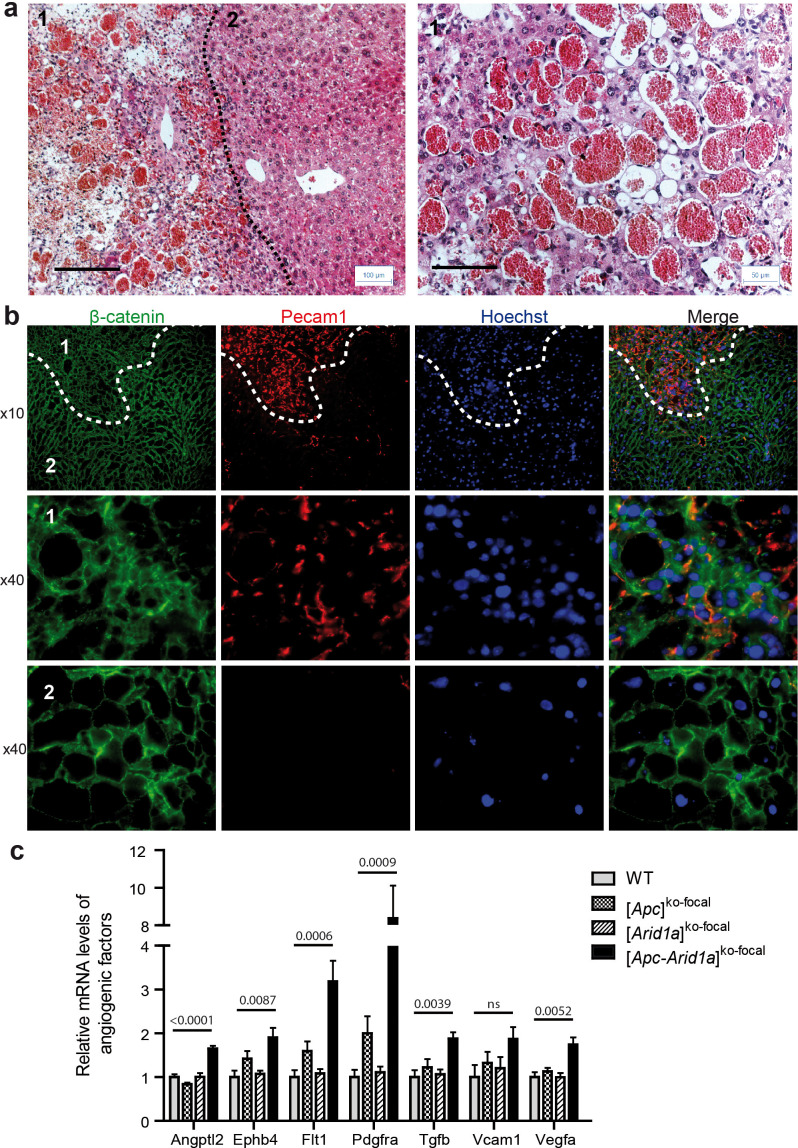
Blood vessel enrichment and angiogenesis in [Apc-Arid1a]ko-focal livers.(a) Peliotic areas appeared as abnormal tangles of irregularly shaped, leaky, small and large blood vessels filled with red blood cells, with multiple, mottled cyst-like spaces associated with sinusoidal dilatation and liver cell dropout in the livers of [Apc-Arid1a]ko-focal mice (1), relative to neighboring tissue (2). Scale bars = 200 μm (left panel) and 100 μm (right panel). (b) Immunofluorescence, at different magnifications, against β-catenin and Pecam1 of [Apc-Arid1a]ko-focal liver. Peliosis-like area, showing strong enrichment of blood vessels (1) compared to neighboring tissue (2). (c) RT-qPCR analysis of angiogenic factors from 7-month-old-mouse livers. WT (n = 5), [Apc]ko-TOTAL (n = 7), [Arid1a]ko-TOTAL (n = 12), and [Apc-Arid1a]ko-TOTAL (n = 10) mice. Data are presented as the mean + SEM and analyzed by one-way ANOVA.Figure 1—figure supplement 3—source data 1.qPCR expression of angiogenic mRNAs (Figure 1—figure supplements 3c).